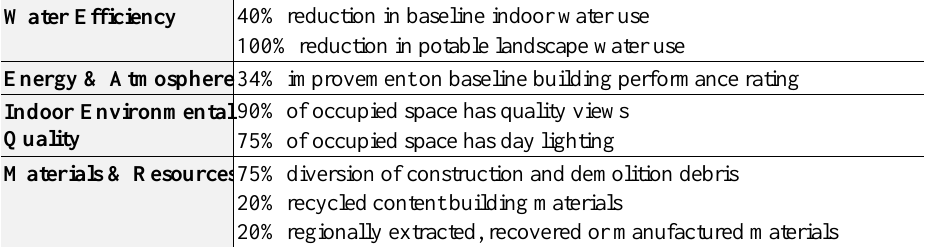
Table 5 – Why is EcoPoint Office Center Kosice “green” Water